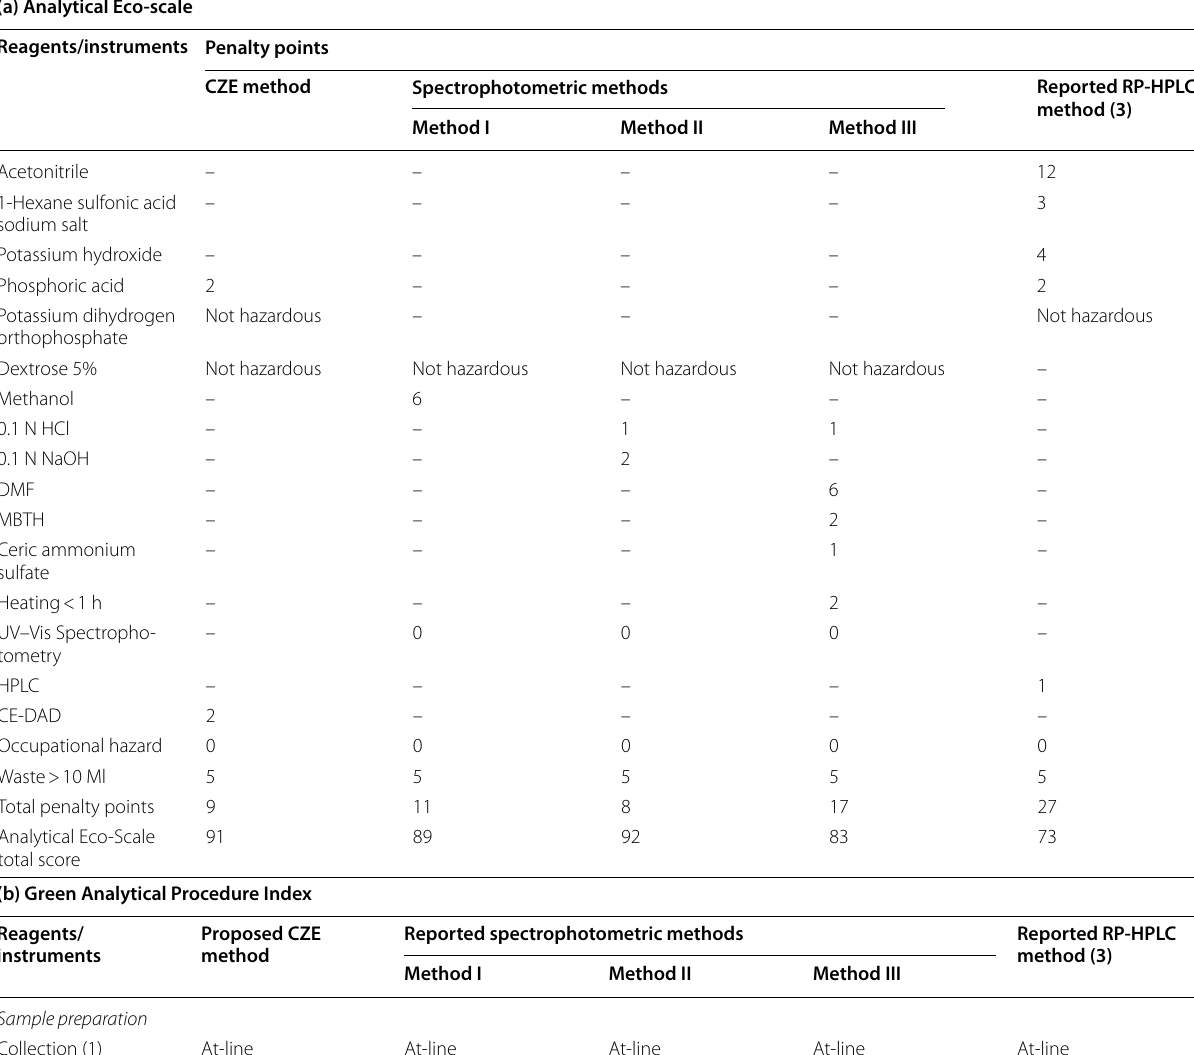
Table 7 The penalty points (a) and Green Analytical Procedure Index (b) for the determination of TIG in intravenous infusion solution (a) Analytical Eco-scale Reagents/instruments Penalty